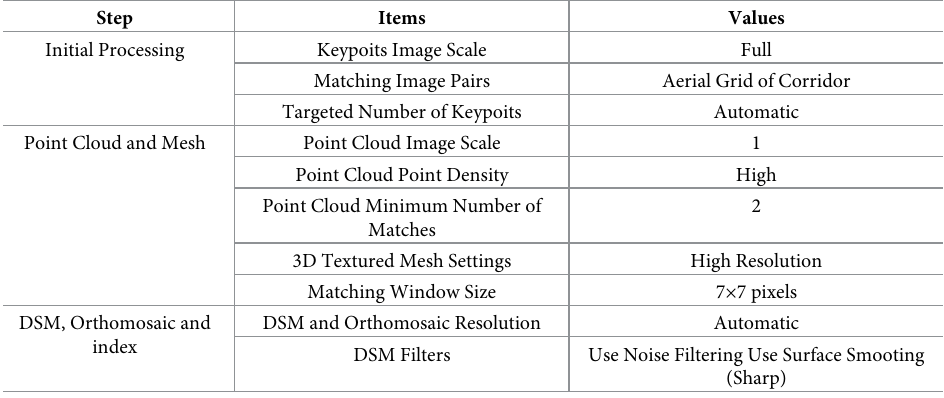
Table 2. Parameters of the Pix4D processing used in this